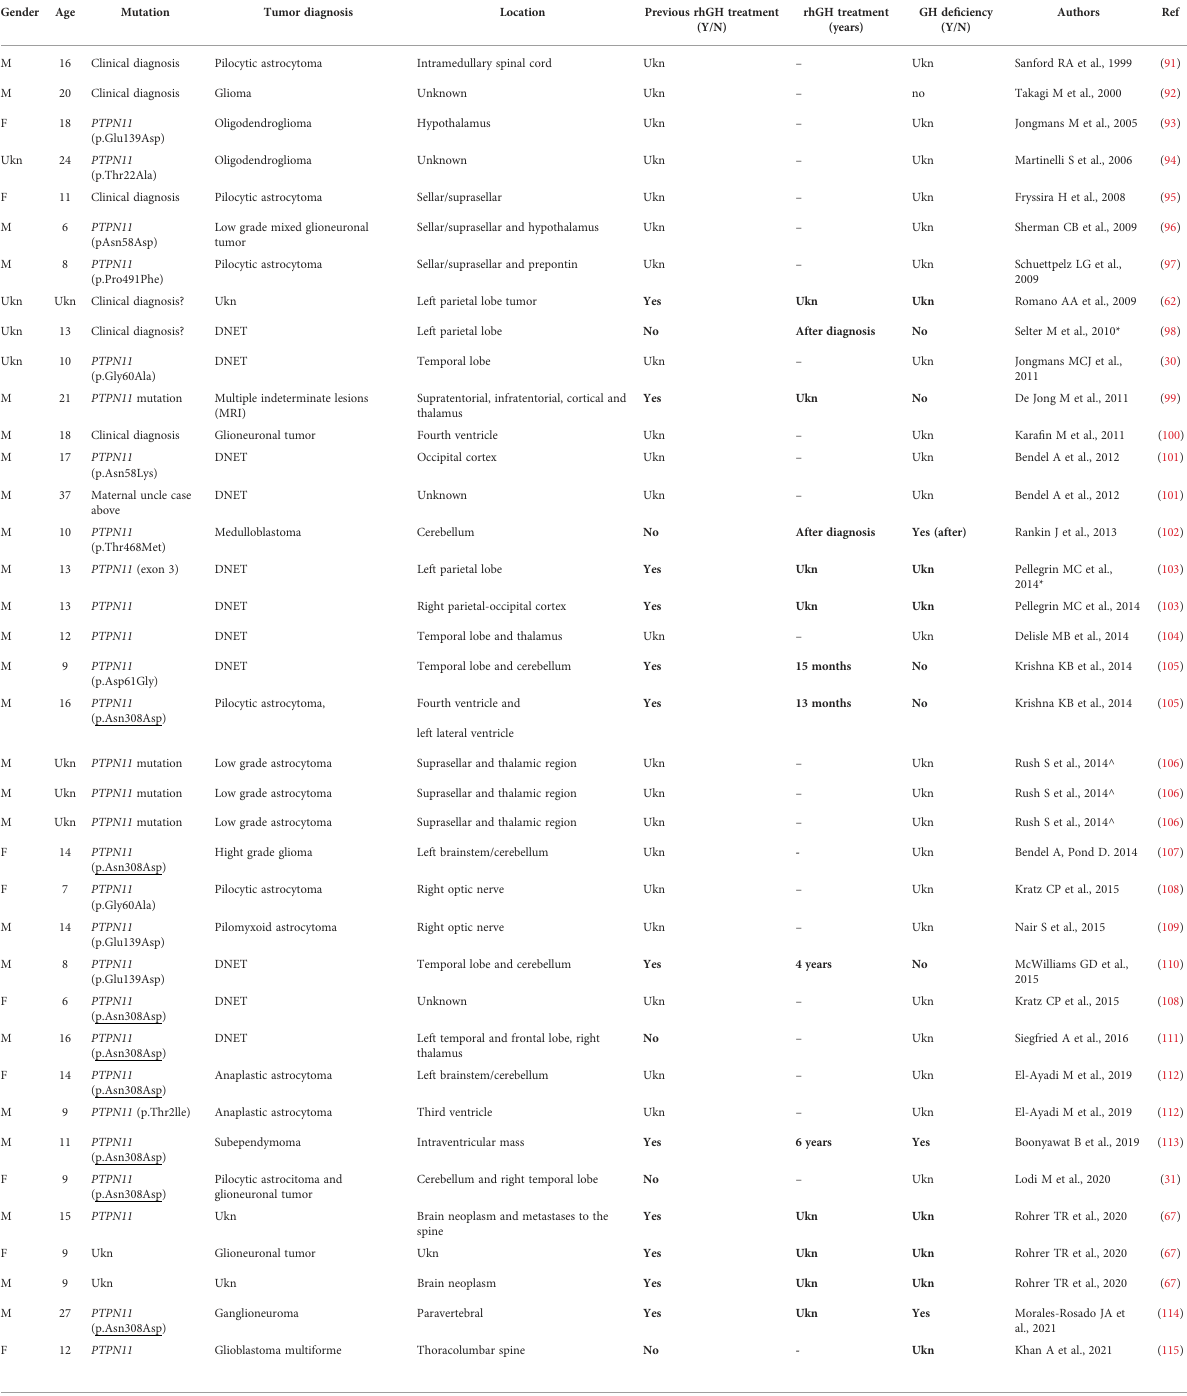
TABLE 3A Primary brain tumors in Noonan syndrome with PTPN11